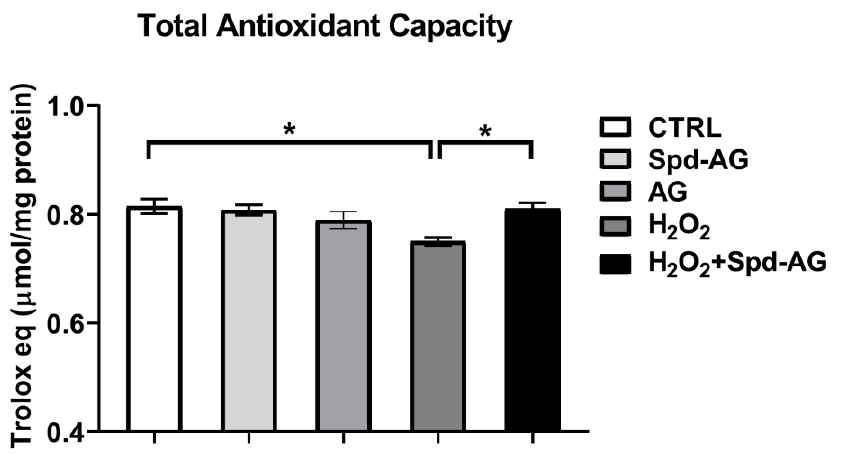
Figure 8. Effect of Spd-AG and H 2 O 2 on C2C12 myoblasts on total antioxidant capacity. C2C12 myoblasts were treated with H 2 O 2 0.3 mM, AG, 1 mM, Spd, 10 µ M and combined treatments for 24 h. Cell lysates. TAC was expressed as micromole Trolox equivalents/mg of protein tested. Data presented are the mean ± SEM of three experiments, each performed in triplicate. A one-way ANOVA followed by Bonferroni’s multiple comparisons test was performed. * p <